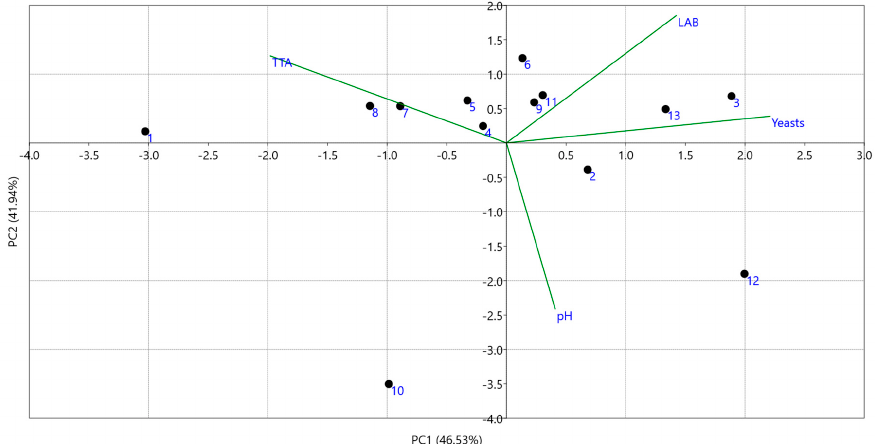
Figure 1. Correlation-based Principal Component Analysis (PCA, biplot) of the sourdough samples with the measured physicochemical and microbiological parameters of pH, total titratable acidity (TTA, in% lactic acid), lactic acid bacteria (LAB, in log CFU / g) and yeasts (in log CFU / g) Table 2. Physicochemical and microbiological data of 13 Greek wheat sourdoughs .